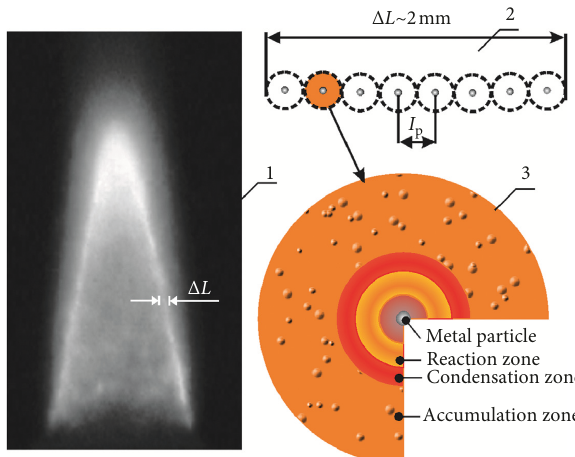
Figure 2: Structure of the combustion zone of the dust flame and microflame of an aluminum metal particle ( d p � 4.8 μ m, C f � 0.4 kg/m 3 ) [12]. 1, laminar dust flame; 2, combustion zone; 3, microflame